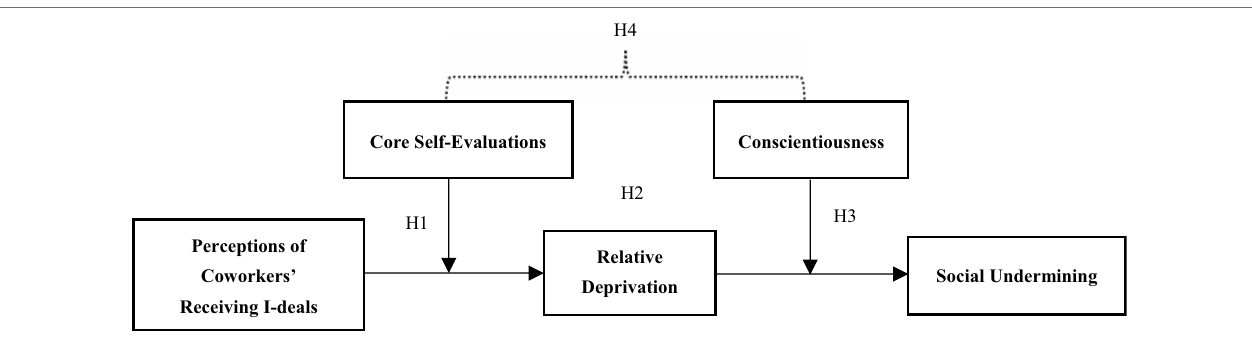
FIGURE 1 | Conceptual